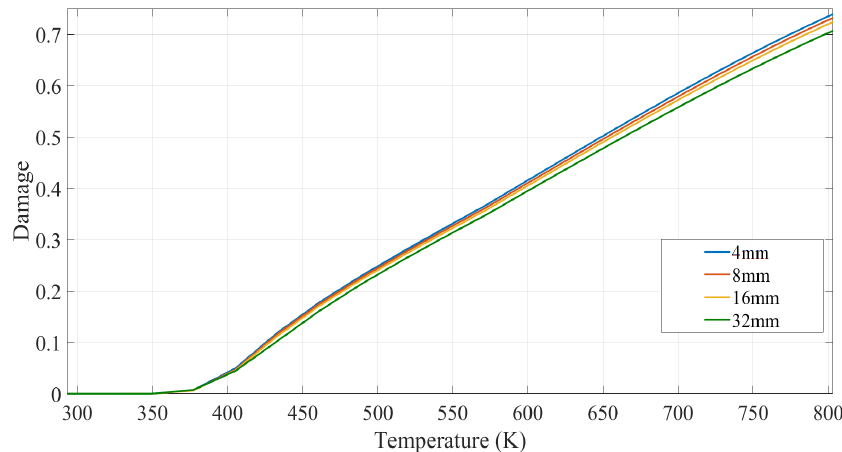
Figure 15. Damage x Temperature relation for concretes with different aggregates grading.